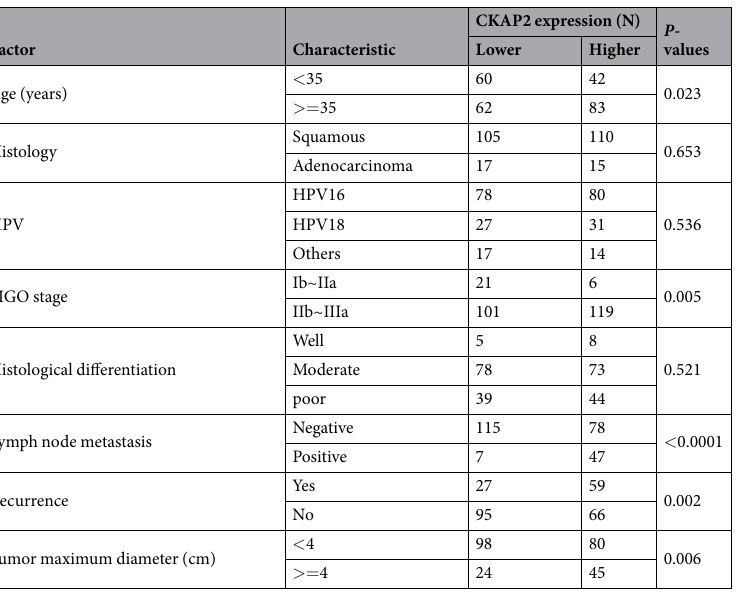
Table 1. Relationship between CKAP2 and clinical characteristics of cervical carcinoma patients. Pearson Chi- square